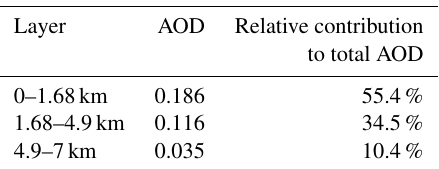
Table A30. Selection of different aerosol layers on 8 July (07:00–